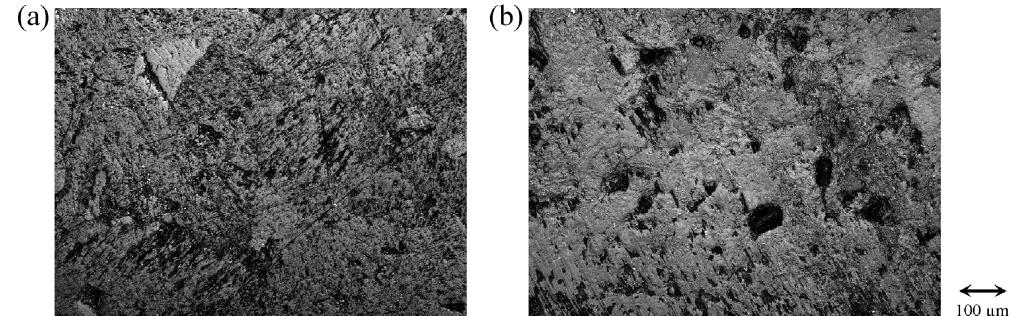
Fig. 13 Images of the granite counter surface on an area of 660 µm × 877 µm: (a) clean counter surface, (b) “polluted” counter surface is found after the test of composite 15 EF at a contact pressure of 0.25 MPa.